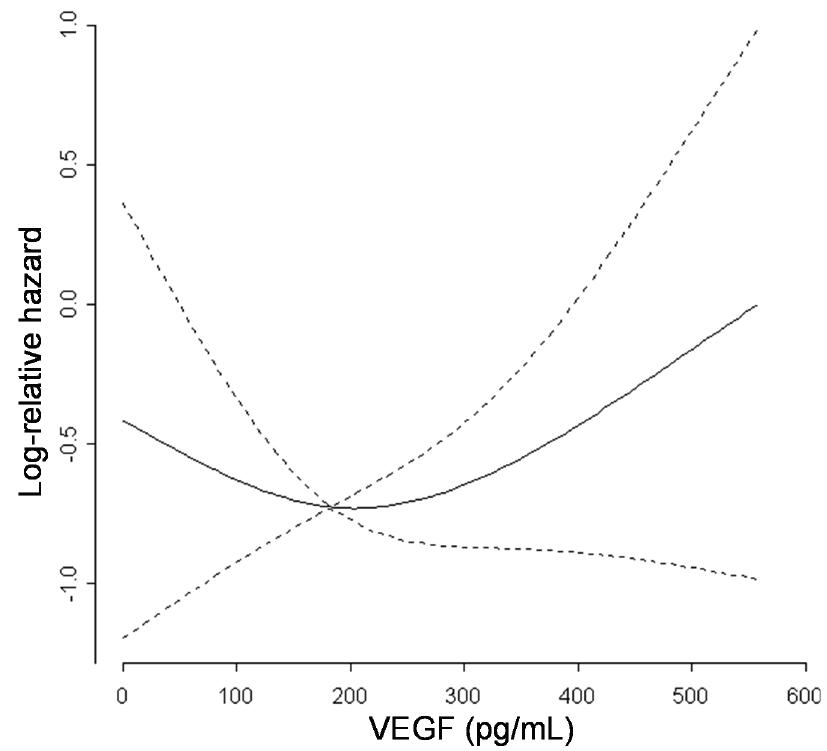
Figure 2. Relationship between the risk of death and baseline VEGF levels. The risk of death was measured by the log-relative hazard from the multivariable Cox model for OS. Continuous line: log-relative hazard plot; dotted lines: 95% log-relative hazard confidence